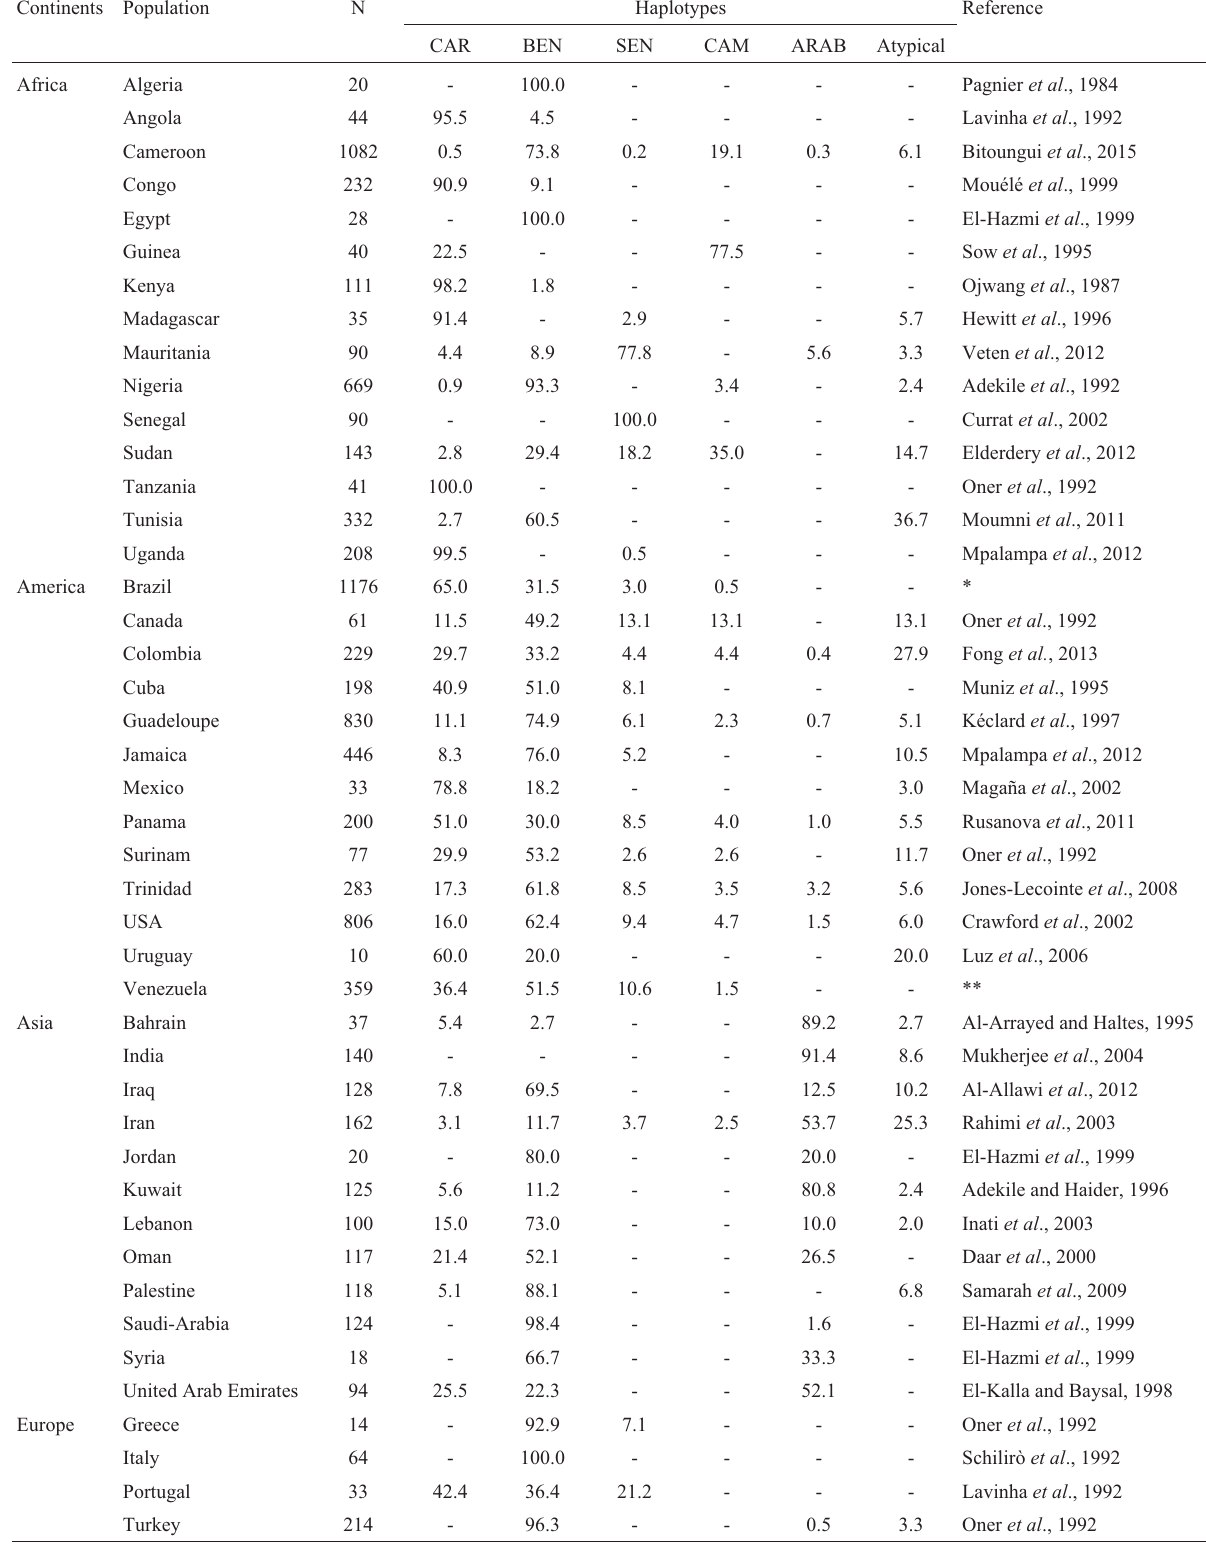
Table 2 - Frequency (%) of HBB*S haplotypes in different world populations. Continents